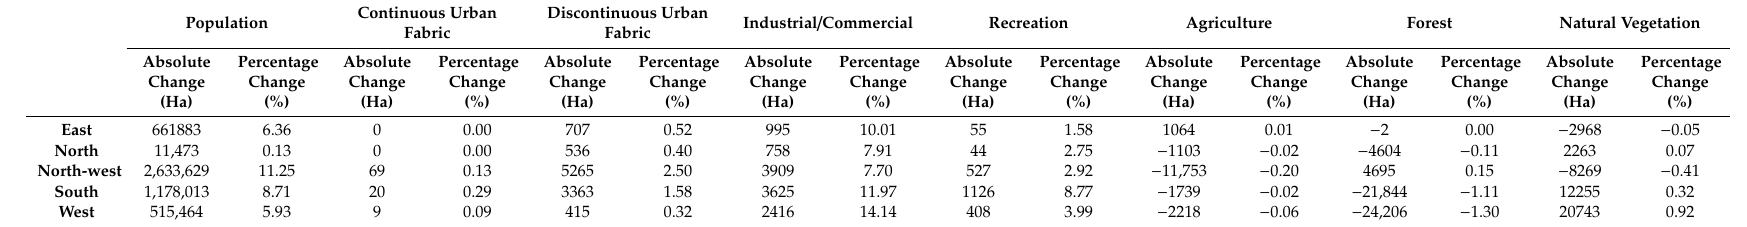
Table 4. Regional dynamics for land-use and population between 2000 and 2006.